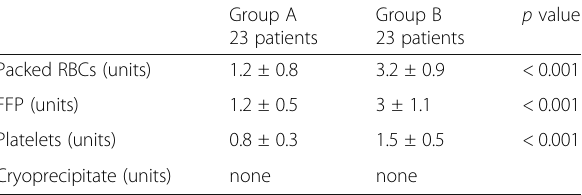
Table 3 Postoperative blood and product transfusion